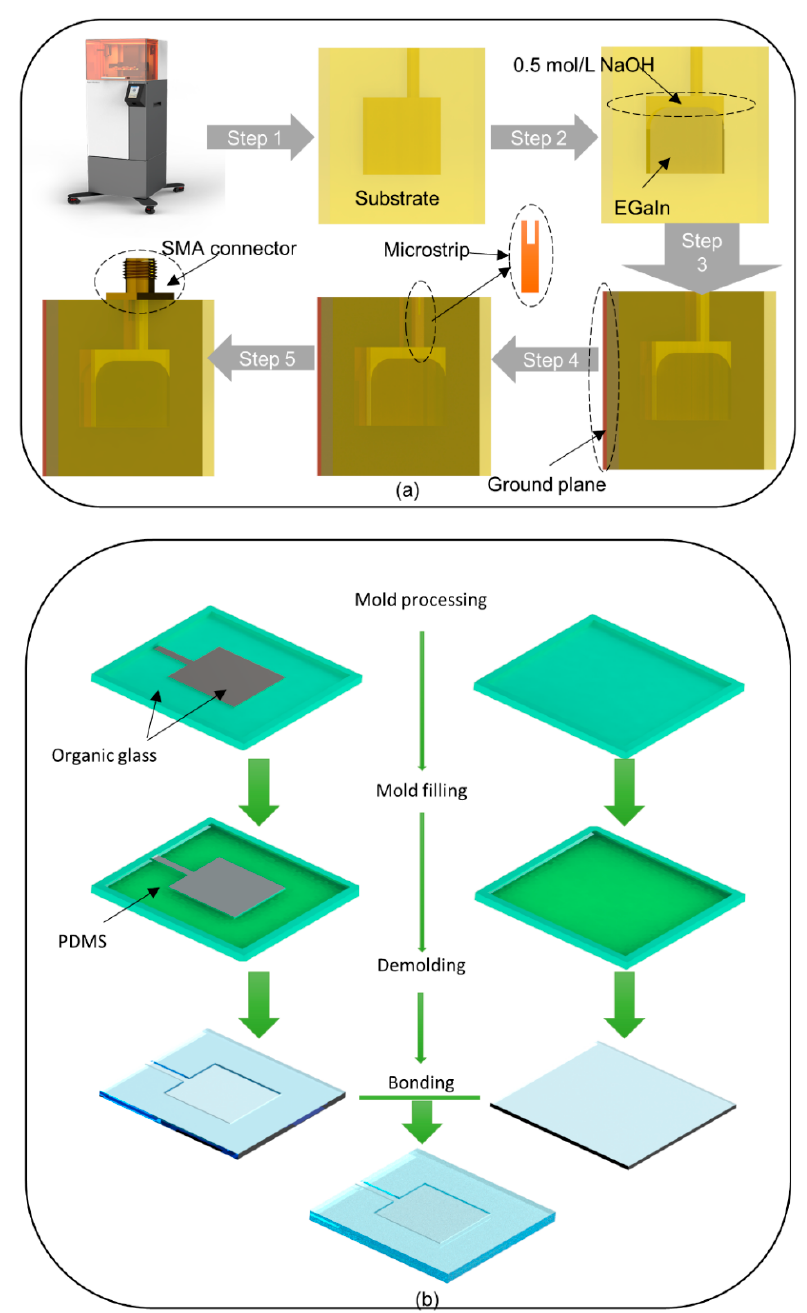
Figure 3. ( a ) Process flow diagram of the antenna manufacturing based on 3D printing. ( b ) Part